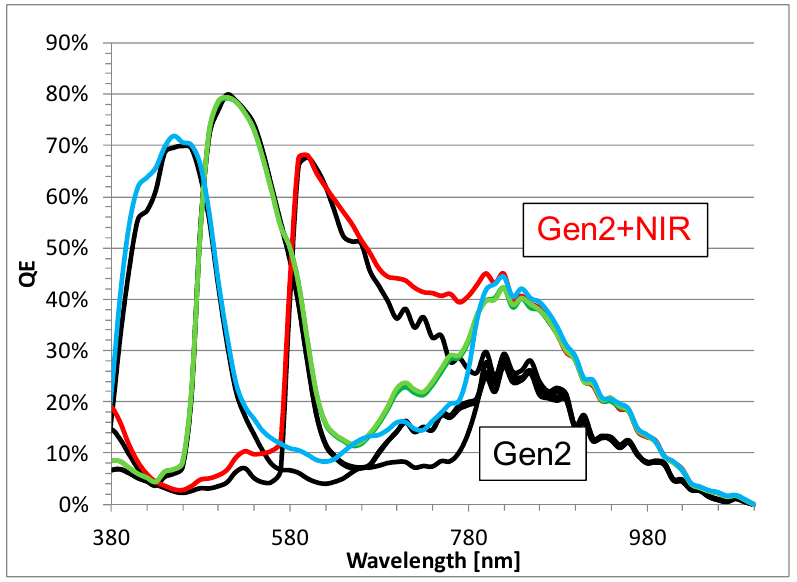
Figure 10. QE comparison from a 1 µm, 16MP Gen2 image sensor to one with an additional process for NIR enhancement.